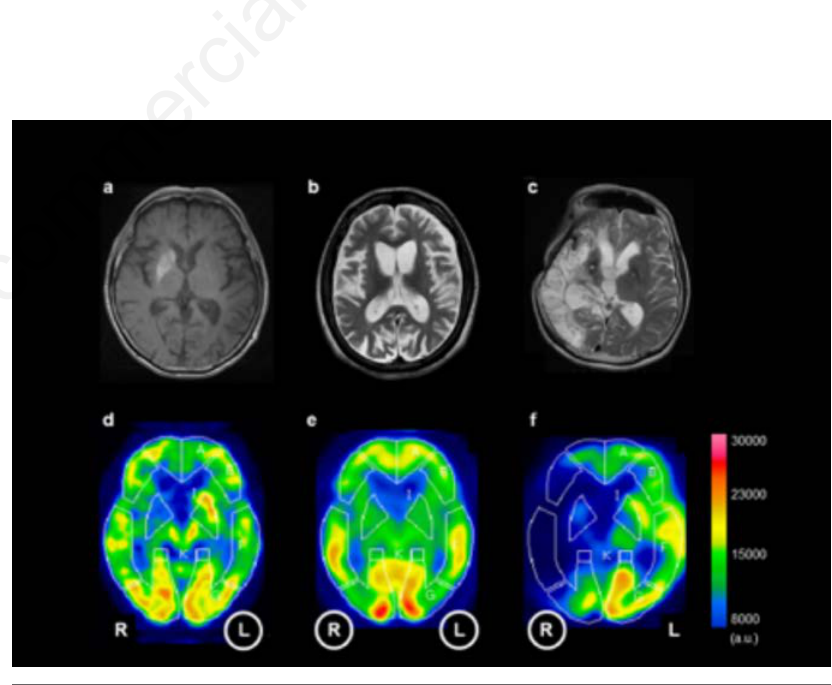
Figure 2. Brain magnetic resonance imaging (A-C). (A, Patient 1) T1 hyperintensity in the right basal ganglia (TR 756 ms; TE 9.7 ms); (B, Patient 2) Diffuse atrophy of the cerebral cortex and caudate nuclei bilaterally on T2-weighted images (TR 5,000 ms; TE 82 ms); (C, Patient 3) T2 hyperintensity in the supplied area of right middle cerebral artery. Brain 18F-fluorodeoxyglucose positron emission tomography (FDG-PET) (D-F). (D, Patient 1) FDG uptake was reduced in the right striatum (right, 56% compared to that in right occipital lobe; left, 88%). (E, Patient 2) FDG uptake was reduced in the striatum bilater- ally (right, 67%; left, 70%). (F, Patient 3) FDG uptake was decreased in the entire right hemisphere and the left striatum (left, 57%). The side of choreic movements was expressed as circulated R (right) or L